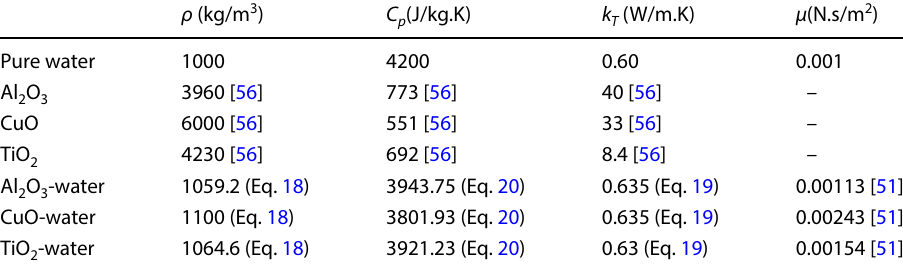
Table 2 Properties of different materials considered for numerical